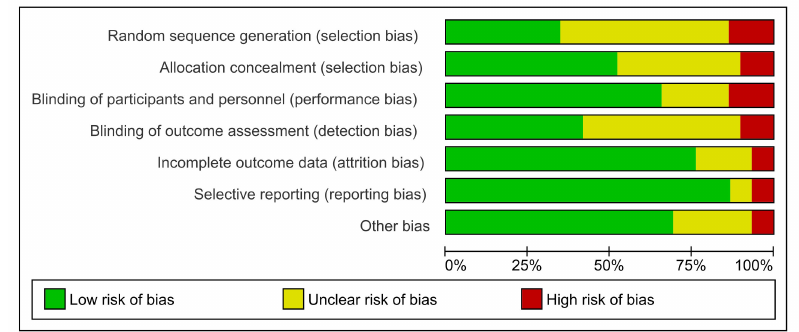
Figure 2. Overall risk of bias for included studies. Data are presented as percentages of risk assessment across 7 predefined